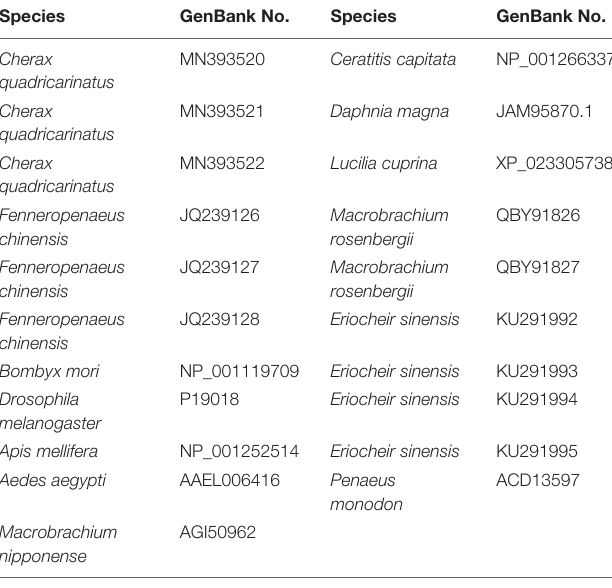
TABLE 2 | Tra2 proteins used for phylogenic